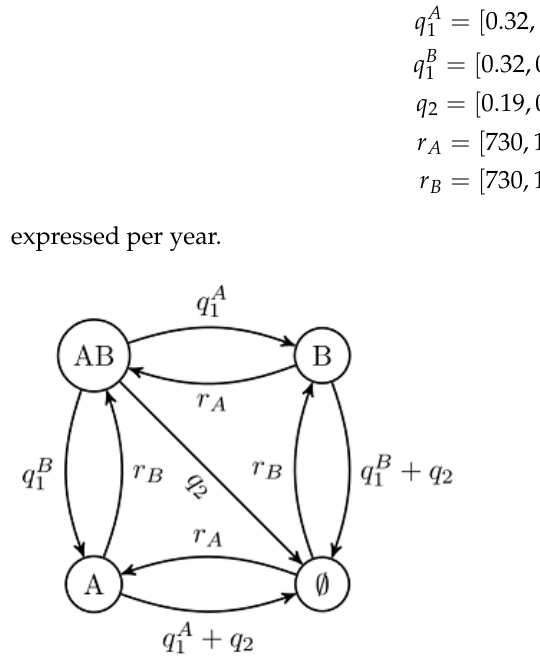
Figure 1. Markov chain for failure with non-instant repair